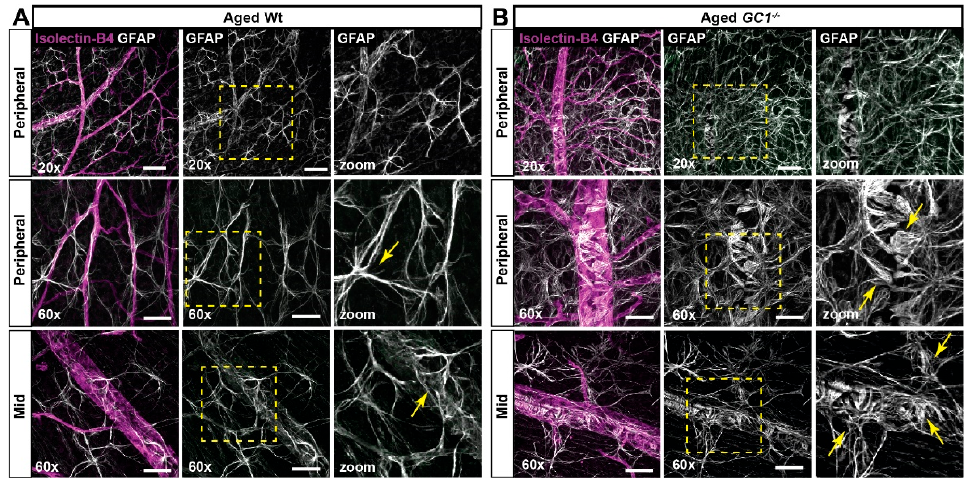
Figure 4. Astrocyte morphology in aged Wt and GC1 − / − retina. ( A ) Representative confocal micro- graphs of astrocytes (GFAP; white) and blood vessels (isolectin B4; magenta) in peripheral and mid retina of aged Wt mice. Astrocyte processes are increasingly striated and frayed (yellow arrows) in proximity to vessels compared with young mice. ( B ) Representative confocal micrographs of astro- cytes (GFAP; white) and blood vessels (isolectin B4; magenta) in peripheral and mid retina of aged GC1 − / − mice. Dense patches of matted astrocytes are observed in proximity to blood vessels at the periphery. End feet appear increasingly bulbous and frayed (yellow arrows) compared to young GC1 − / − animals and Wt mice. Scale bars at 20× = 100 µm and at 60× = 40 µm.